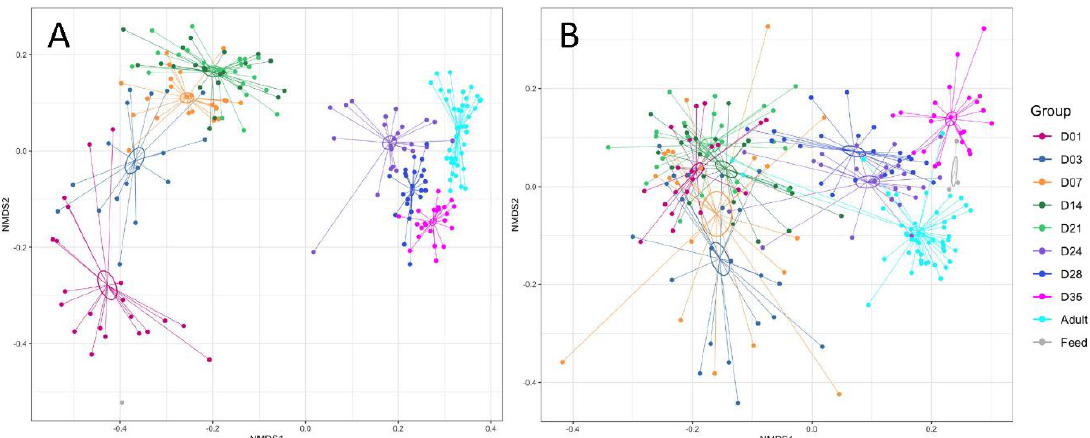
Figure 2. Beta diversity of piglet feces over time. Non-metric multidimensional scaling (NMDS) plot of β-diversity based on Bray–Curtis dissimilarities in the ( A ) bacteriome and ( B ) mycobiome of piglet feces for growth time points D01–35. Outdoor adult fecal samples (Adult), indoor lactating sow fecal samples (Sow) and nursery feed (Feed) are included for comparison only. Ellipses indicate 1 standard error from centroid. The effect of growth time points on piglet fecal communities was determined using permutational analysis of variance tests with the adonis function and strata option (strata = piglet) in the R package vegan.